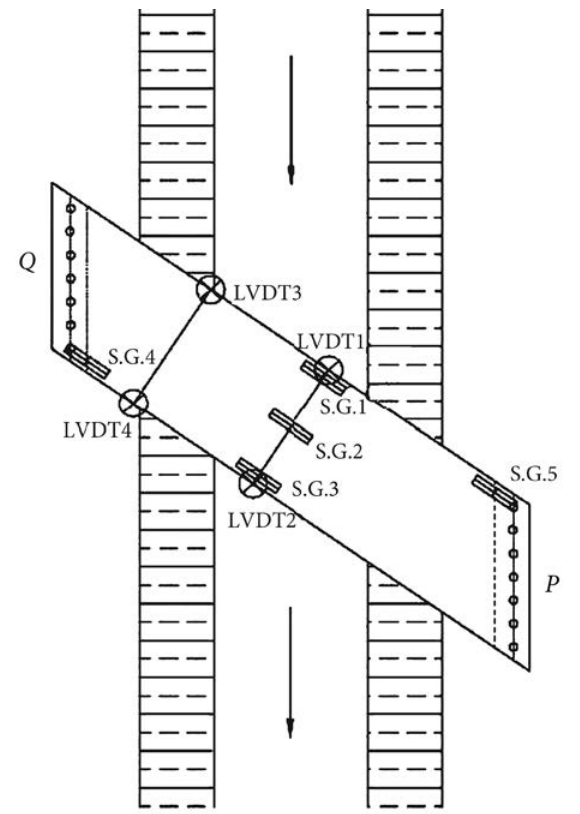
Fig. 5. Locations of STs and LVDTs on bridge slab